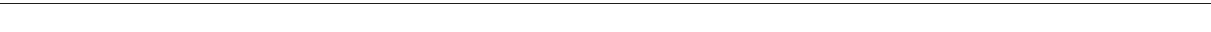
Fig. 5 Slc10a7 − / − mice exhibit long-bone macro- and microstructure defects. a Alizarin red/Alcian blue staining of newborn femurs and measurement of newborn femur length and femur length/width ratio. Scale bars = 1 mm. n = 8 ( Slc10a7 + / + ), n = 9 ( Slc10a7 + / − ) and n = 10 ( Slc10a7 − / − ). b Three- dimensional reconstruction of μ CT analysis of 8-week-old mouse femurs and measurement of 8-week-old femur length and femur length/width ratio. Scale bars = 1 mm. Panels ( a ) and ( b ) demonstrate that Slc10a7 − / − femurs, both at birth and at 8 weeks, are shorter and thicker, and exhibit morphological defects. c Three-dimensional μ CT of sections of 8-week-old distal femur metaphyses from Slc10a7 + / + and Slc10a7 − / − mice. Scale bars = 1 mm. Graphs show trabecular and cortical bone volume (BV/TV) and bone mineral density (BMD). n = 7 ( Slc10a7 + / + ), n = 7 ( Slc10a7 + / − ) and n = 6 Slc10a7 − / − ). d Safranin O staining of the distal femur epiphysis of newborn Slc10a7 + / + and Slc10a7 − / − mice. Right panels show higher magni fi cation of the growth plate. Scale bars = 250 μ m. e Masson ’ s Trichome staining of distal femur epiphysis of newborn Slc10a7 + / + and Slc10a7 − / − mice. Scale bars = 250 μ m. HZ, hypertrophic zone; PHZ, prehypertrophic zone; PZ, proliferative zone; RZ, resting zone. Images are representative of n = 10 and n = 5 per group for Safranin O and Masson ’ s Trichome staining, respectively. Data are expressed as mean ± SD. NS, nonsigni fi cant; * p ≤ 0.05; ** p ≤ 0.0.1; **** p ≤ 0.0001 (two-tailed